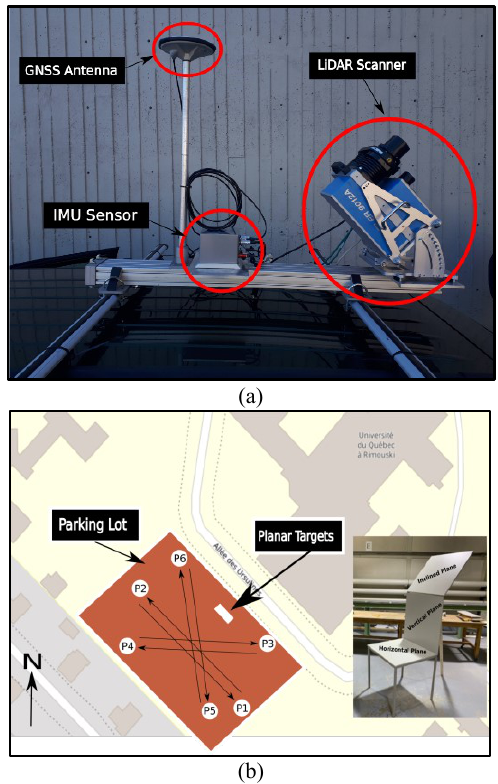
Figure 12 – (a) Terrestrial MLS for validation test